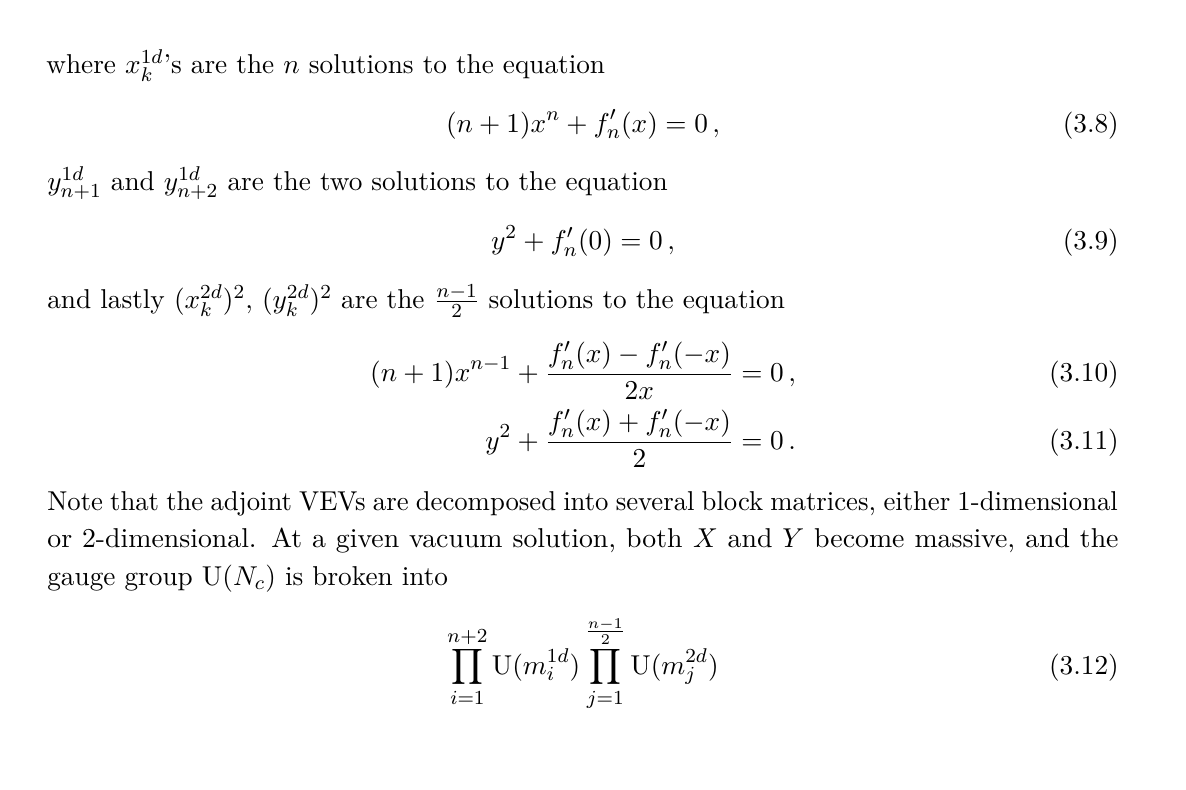
Table 4 . The representations of the chiral operators under the global symmetry groups of the double adjoint theory. The top box is devoted to the elementary fields of Theory A, whereas the middle box is devoted to those of Theory B. Note that the monopole operators of Theory A have the same charges as the gauge singlets V ± of Theory B. On the other hand, the charges of the , W ± s,t u monopole operators of Theory B are given in the bottom box where ˜ N is the dual gauge rank given c by ˜ N = 3 nN . The indices of V ± satisfy st = 0 c f − N c s,t